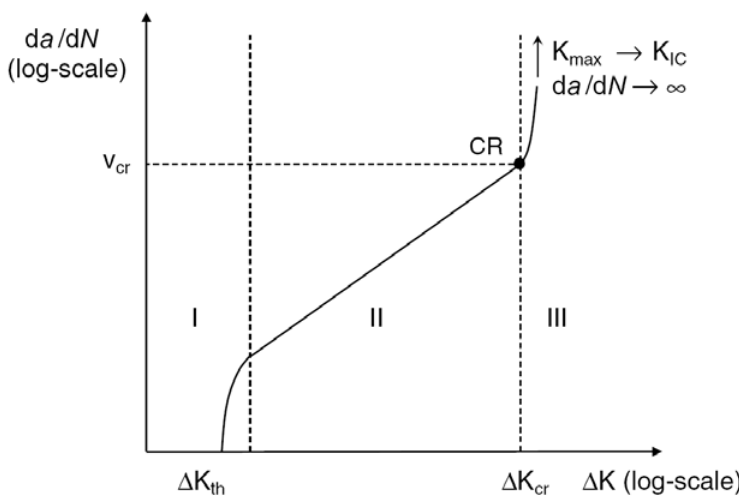
Figure 1. Scheme of the typical fatigue crack propagation curve